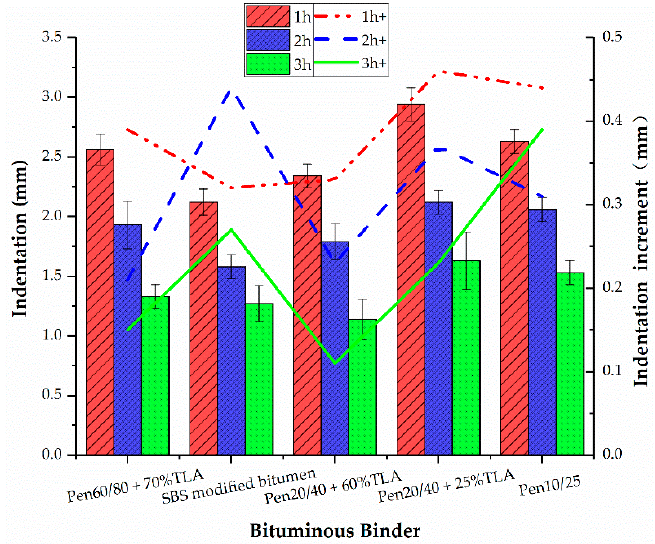
Figure 3. E ff ect of bituminous binder on the indentation Figure 3. Effect of bituminous binder on the indentation test. Figure 3. Effect of bituminous binder on the indentation test.